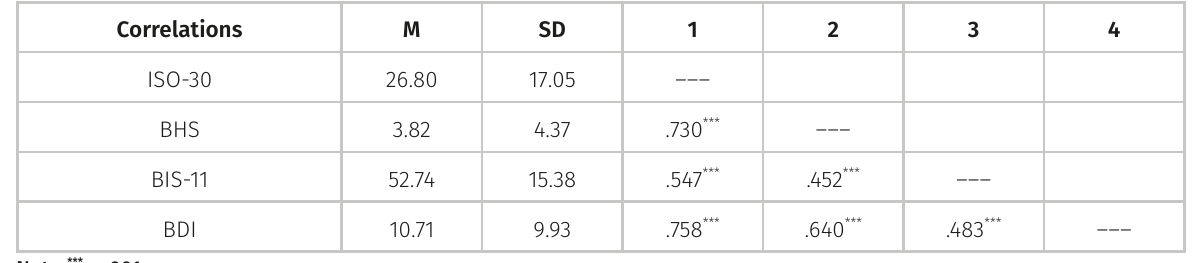
Table II. Spearman’s correlation coefficient (Rho).